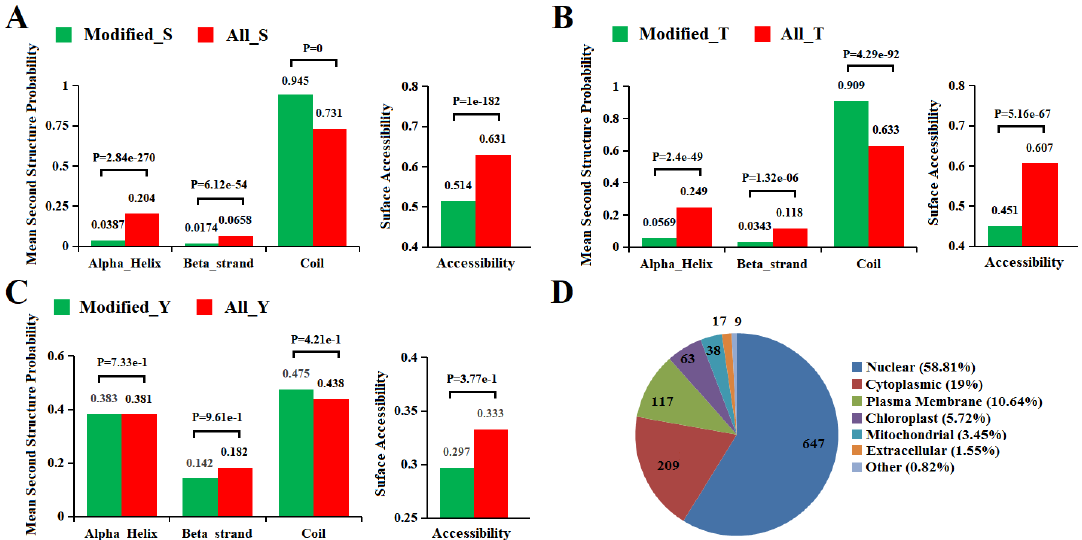
Figure 4. Bioinformational analysis of phosphorylation sites. ( A – C ) Comparison of phosphoproteins and nonphosphoprotein amino acids in protein secondary structures and surface accessibility. ( D ) Distribution of the DEPPs in subcellular compartments.